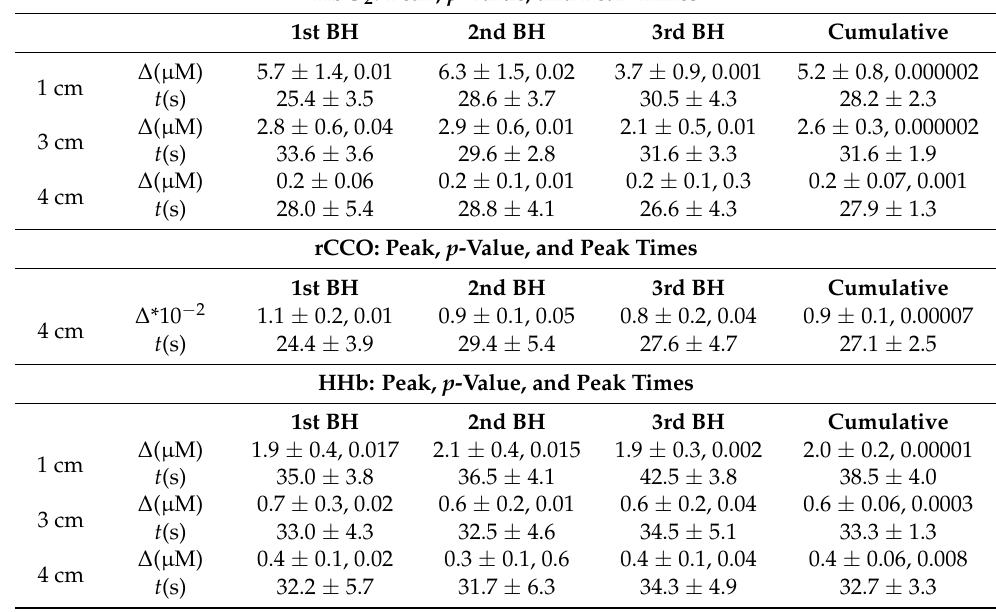
Table 1. Cross-subject average peak magnitudes, p -values, and peak times obtained from the ho- mogeneous semi-infinite diffusion analysis. The peak magnitudes were measured from the 20 s averaged values before BHs. The peak times measured from the beginning of BHs were found in the averaged traces shown in Figure 4 with the errors estimated as the mean absolute deviation from the individual data.